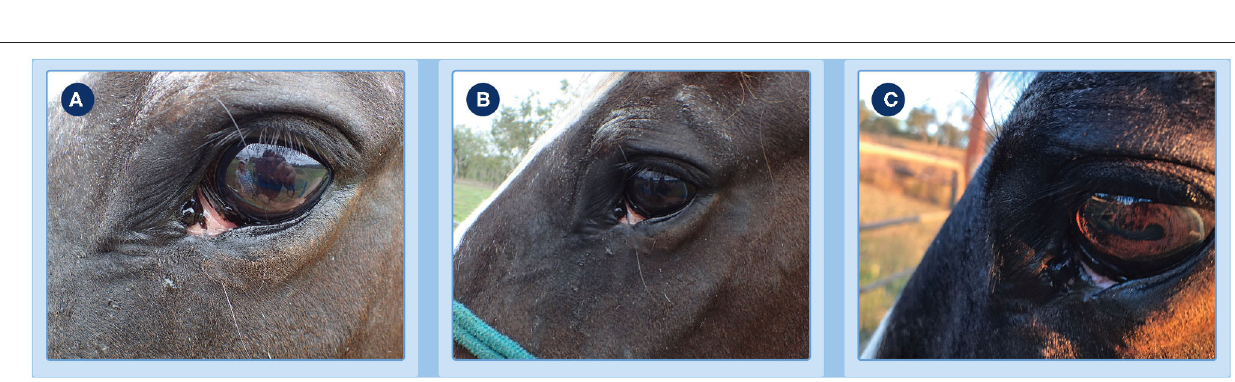
i. A 30% lower intratumoural dose rate (0.35 mg drug/cm